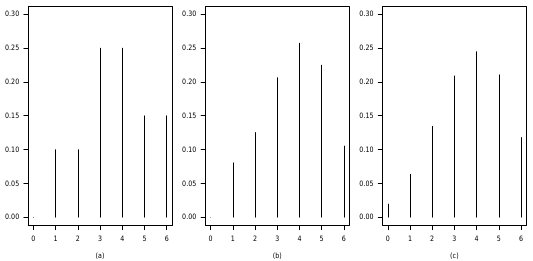
Figure16– Empiricaldistributionfromthedataset, inpanel(a), fittedpowerbinomialdistribution { r ( ˆ θ , ˆ α ) } , in panel (b), and fitted intermediate binomial distribution { q i